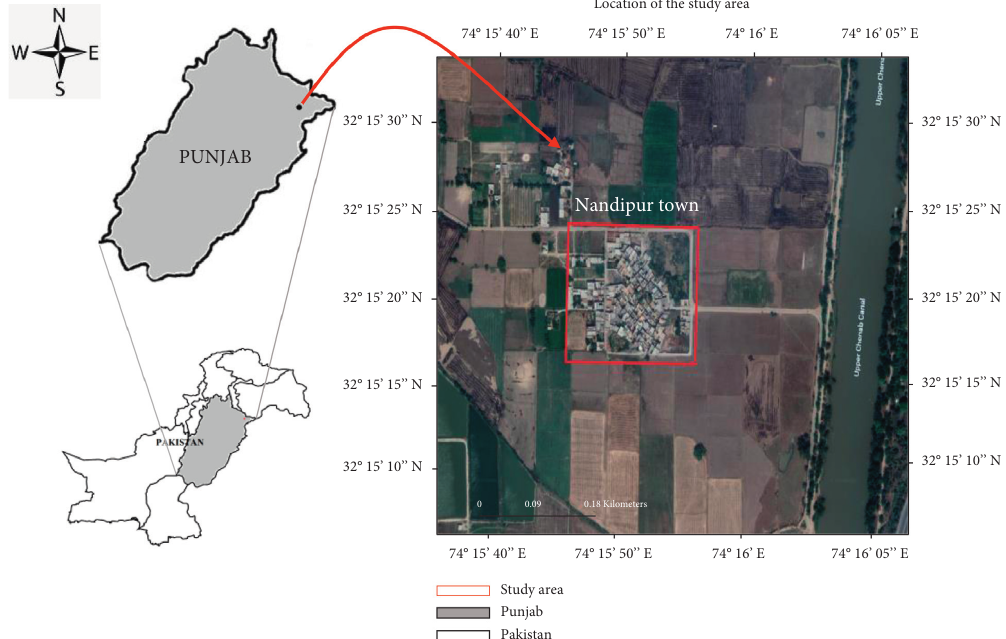
Figure 1: Location of the study area